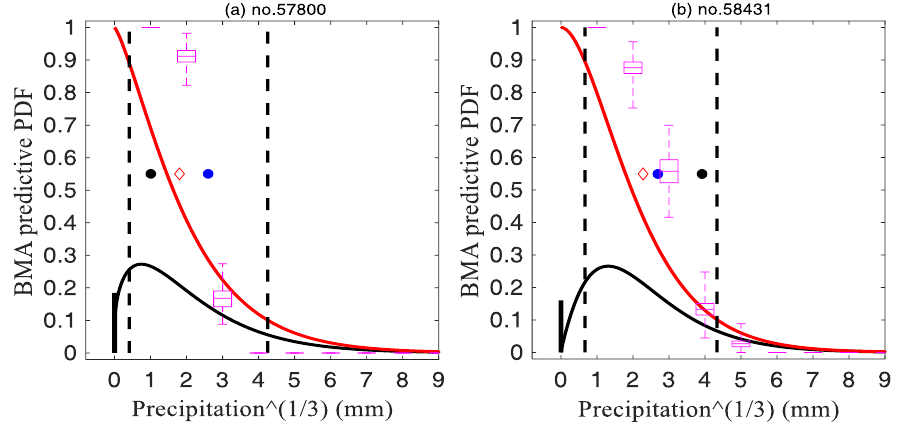
Figure 6. The BMA total probability density function (PDF) from BMA and the box plot of RAW probability forecasts statistical distribution calculated by bootstrapping (resampled 1000 times) for 24 h accumulated precipitation at the 24 h lead time at station no. 57800 ( a ) and no. 58431 on 7 August 2018 ( b ). The upper and lower ends of the boxes are the upper and lower quartiles, respectively; the bars through the boxes are the medians; and the upper and lower ends of the whiskers are the maxima and minima, respectively. The thick black vertical line is the discrete probability of non-precipitation. The red curve is the cumulative probability distribution function (CDF). CDF is the proportion of the area under the BMA PDF to the right of the precipitation amount, multiplied by the probability of precipitation (PoP). The black curve is the conditional PDF given that precipitation is nonzero, the dashed vertical line on the left (right) is the 10th (90th) percentile of the total PDF, the black dot is the verifying observation, the blue dot is the ensemble mean forecasts, and the red diamond is the deterministic forecast of BMA.